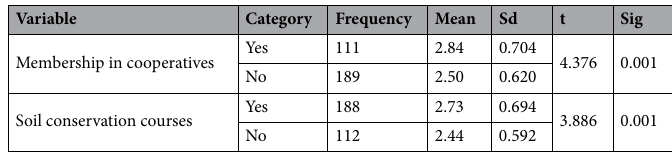
Table 2. The compare of farmers’ SCBs based on two-level